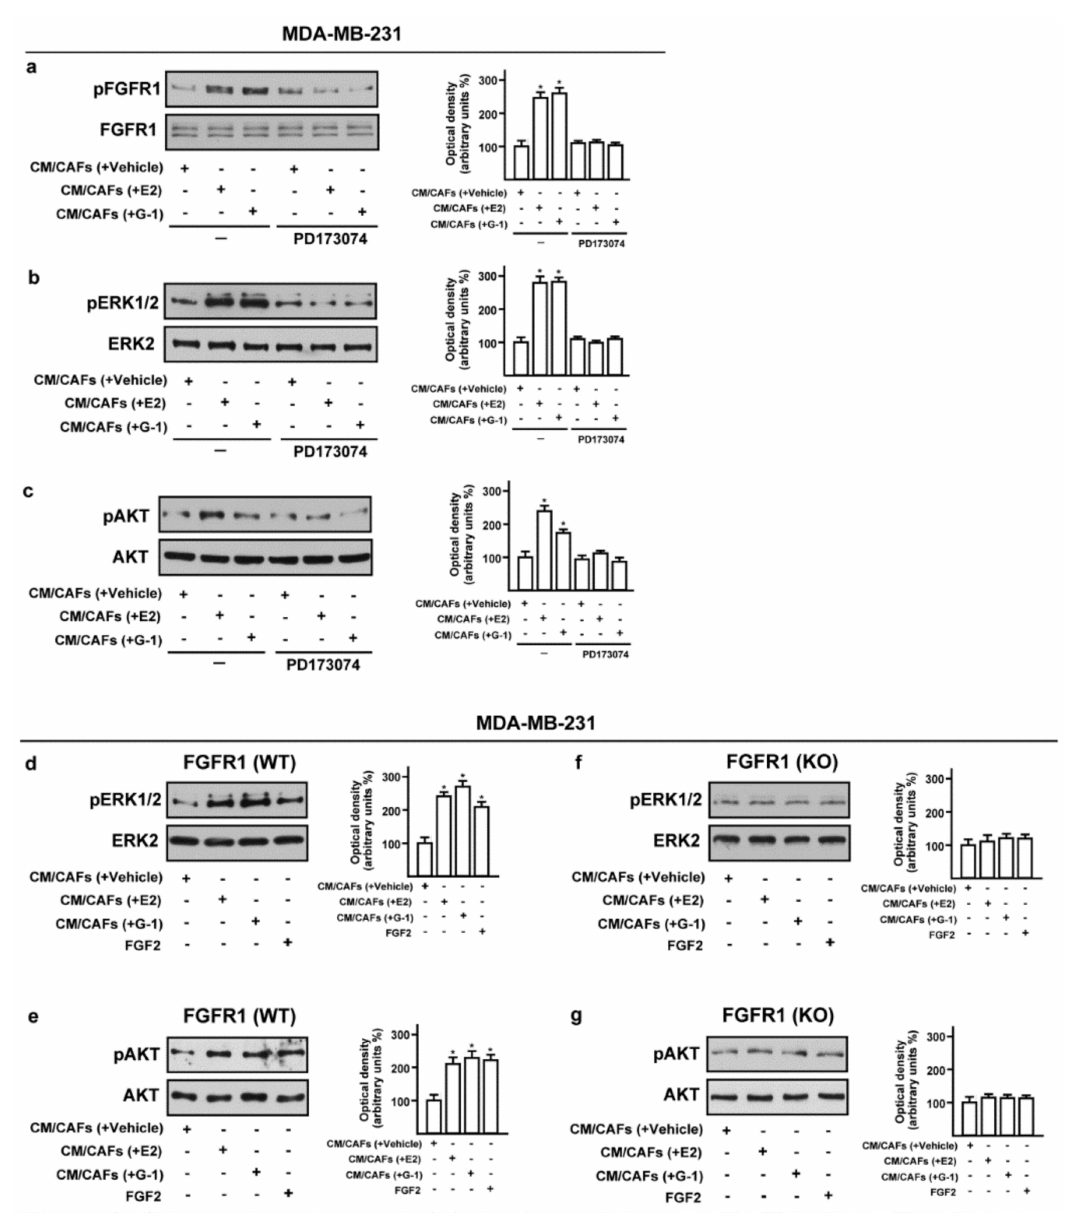
Figure 5. Conditioned medium (CM) from estrogen-stimulated CAFs induces the activation of FGFR1- signaling pathway in MDA-MB-231 cells. ( a – c ) Phosphorylation of FGFR1, ERK1/2, AKT in MDA-MB-231 cells exposed for 1 h to CM from CAFs treated for 18 h with vehicle [CM/CAFs (+vehicle)], 10 nM E2 [CM/CAFs (+E2)] or 100 nM G-1 [CM/CAFs (+G-1)], alone and in the presence of 1 µ M FGFR1 inhibitor PD173074. ( d , e ) Activation of ERK1/2 and AKT in FGFR1 (WT) MDA-MB-231 cells upon exposure for 1 h to CM from CAFs treated for 18 h with 10 nM E2 [CM/CAFs (+E2)], 100 nM G-1 [CM/CAFs (+G-1)]; ( f , g ) In FGFR1 (KO) MDA-MB-231 cells cultured in the same conditions as described above, the activation of ERK1/2 and AKT was no longer observed. FGF2 at 25 nM was used as positive control. FGFR1, ERK2, AKT and β -actin served as loading control, as indicated. Side panels show densitometric analysis of the blots normalized to the loading controls. Immunoblots shown are representative of three independent experiments. (*) indicates p <